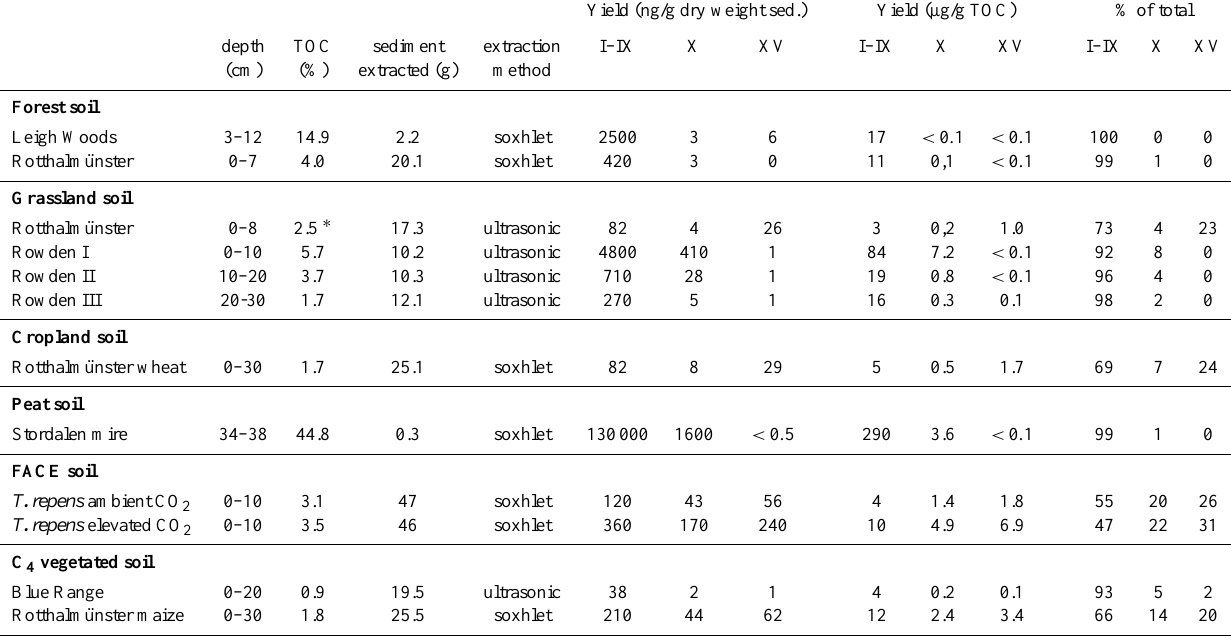
Table 1. Soils used in this study, with concentrations of the different GDGT membrane lipids. I–IX are the branched GDGTs, X is the acyclic isoprenoid “GDGT-0” and XV is the cyclohexane-bearing isoprenoid GDGT “crenarchaeol”. Roman numerals refer to Fig. 1. Yield (ng/g dry weight